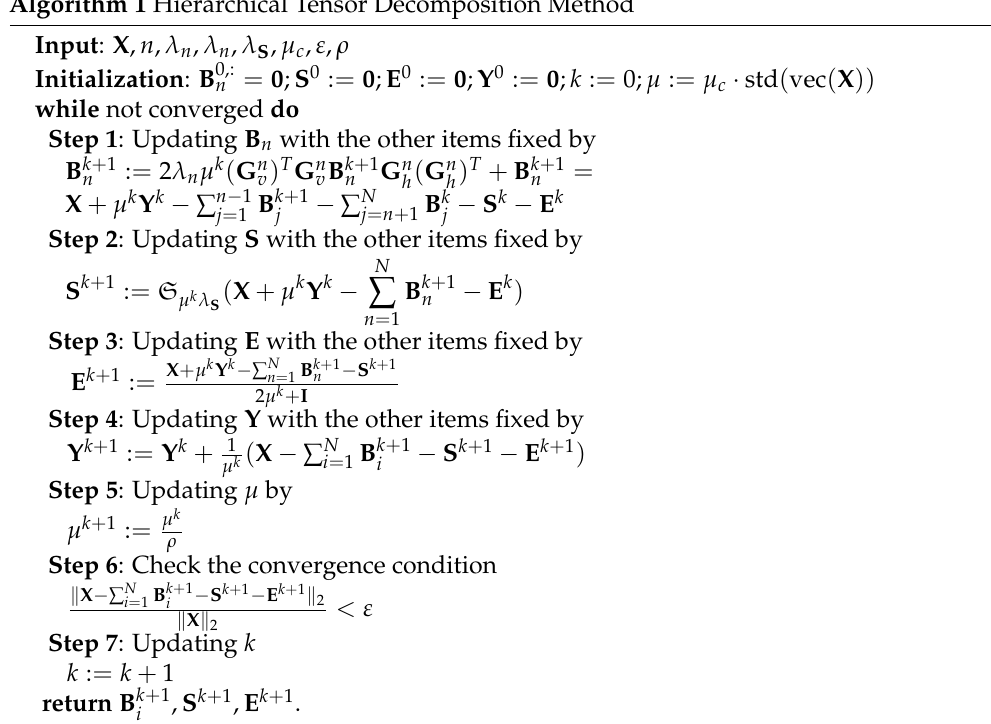
Algorithm 1 Hierarchical Tensor Decomposition